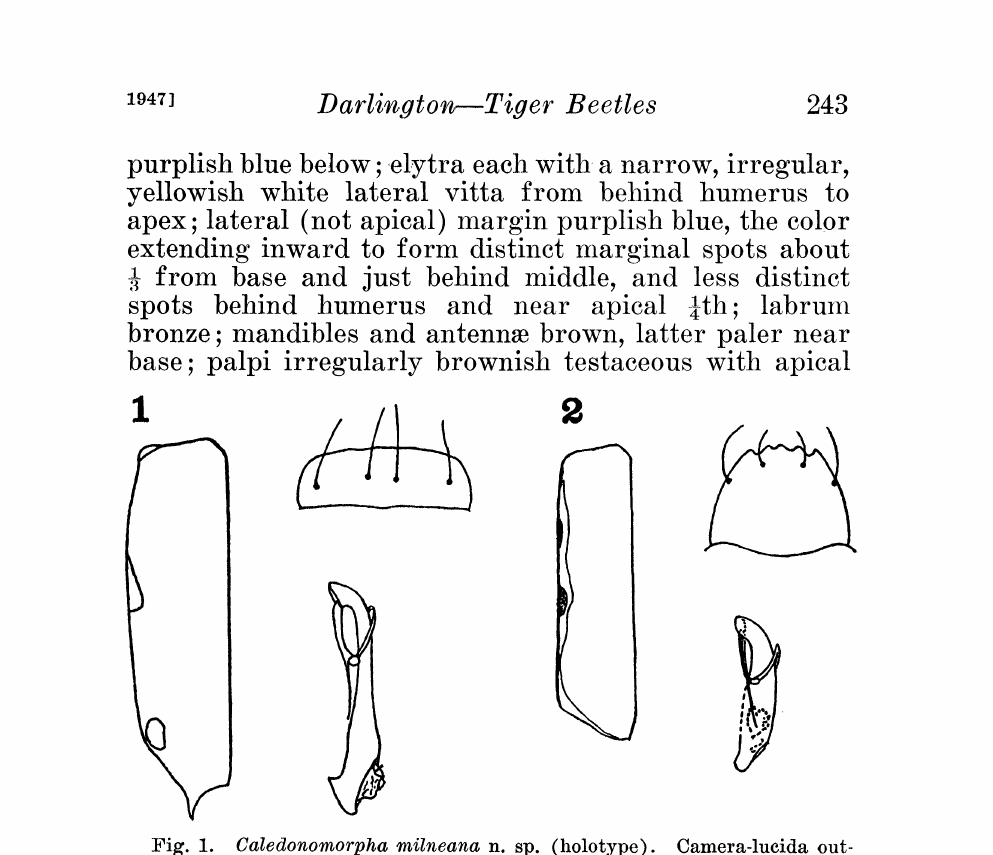
Fig. 1. Caledonomorpha milneana n. sp. (holotype). Camera-lucida out- lines of left elytron (from perpendicular to suture) labrum and male geni- talia (from left, with left paramere). Fig. 2. Prothyma papua n. sp.